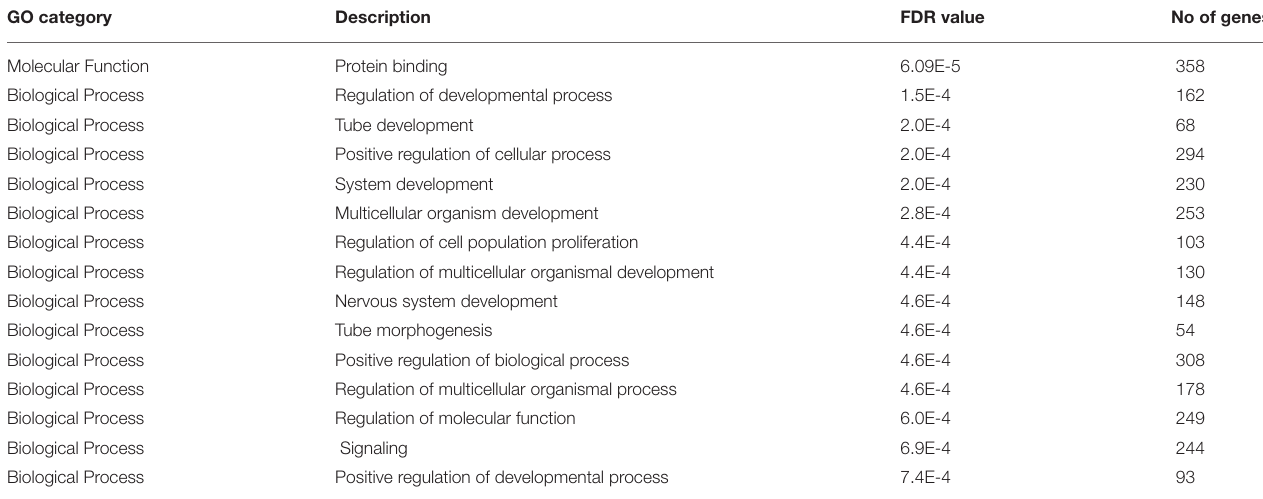
TABLE 4 | Gene ontology (GO) terms with the strongest enrichment in the analysis of all differentially expressed transcripts in the comparison between alpha-synuclein-overexpressing and GFP-expressing LUHMES cells.